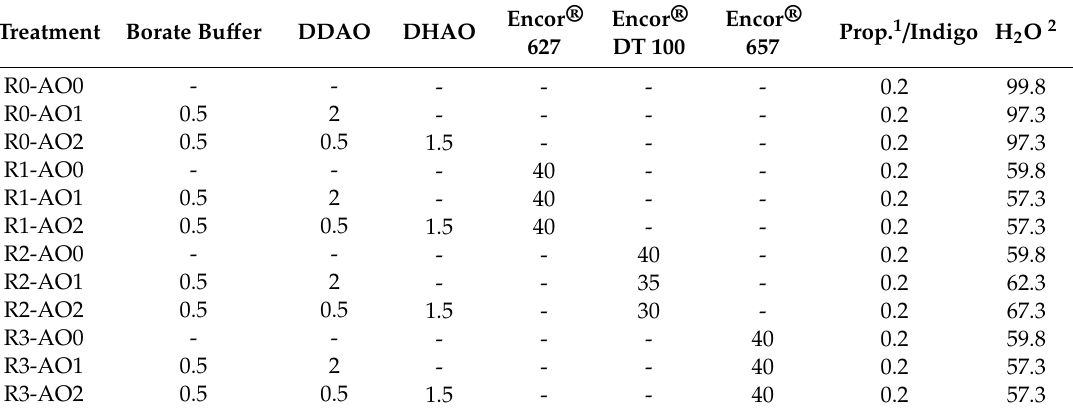
Table 4. Treatments that were used in each test